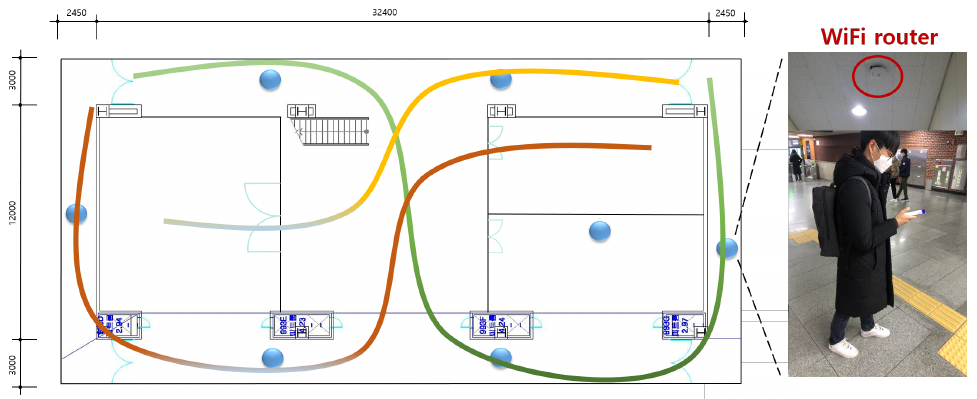
Figure 1. Multiple fingerprinting indoor